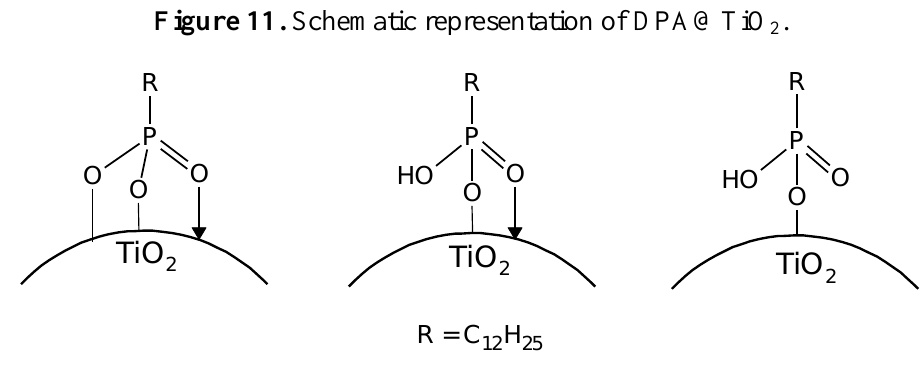
Figure 11. Schematic representation of DPA@TiO